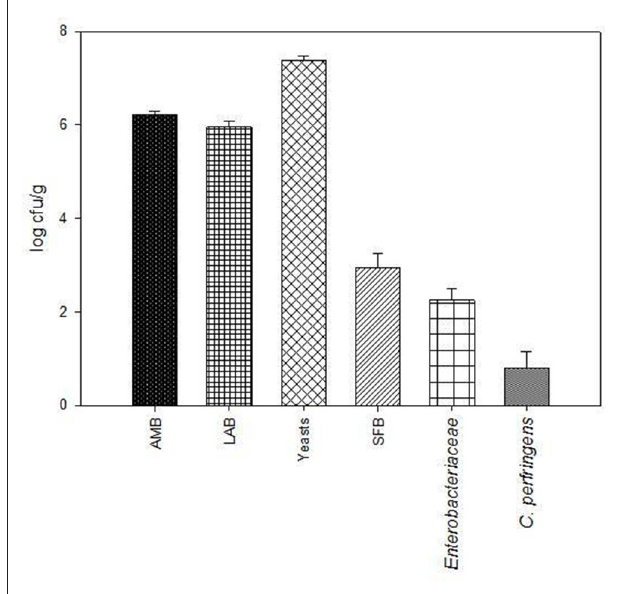
FIGURE 1 | Microbiological characteristics of grape pomace (GP). The microbial loads (log cfu/g) of total aerobic mesophilic bacteria (AMB),